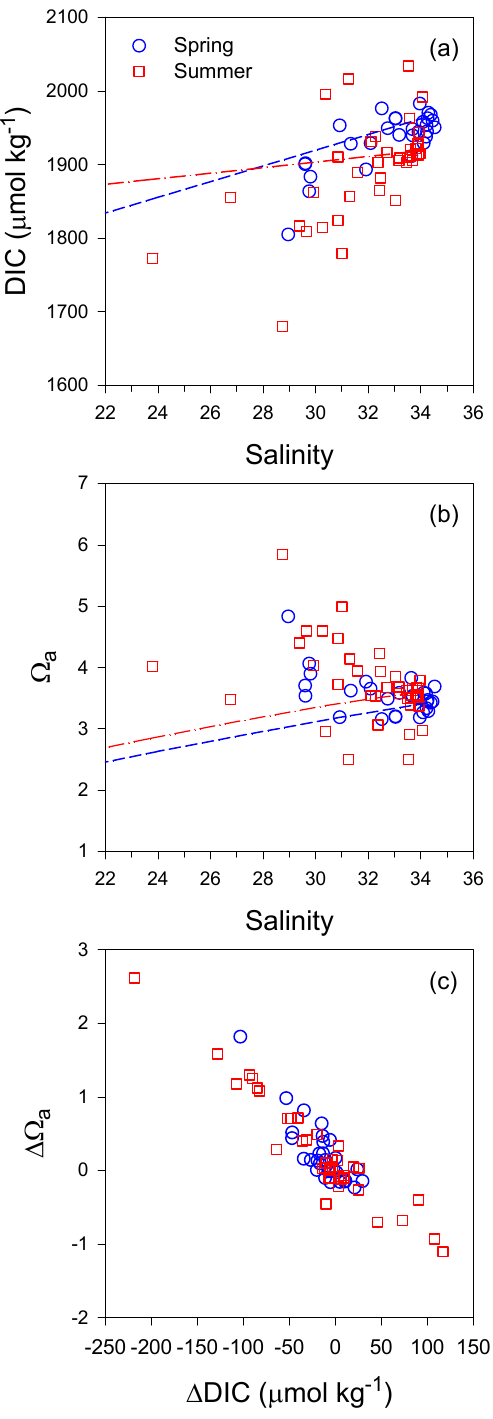
Fig. 7. Plots of (a) DIC vs. salinity, (b) (cid:127) a vs. salinity, and (c) 1(cid:127) a vs. 1 DIC for the surface waters in the East China Sea in spring and summer 2009. The superimposed lines represent the hypothet- ical conservative mixing lines between the freshwater and seawater end-members. 1(cid:127) a and 1 DIC denote the difference between the measured values and the hypothetical conservative-mixing values.